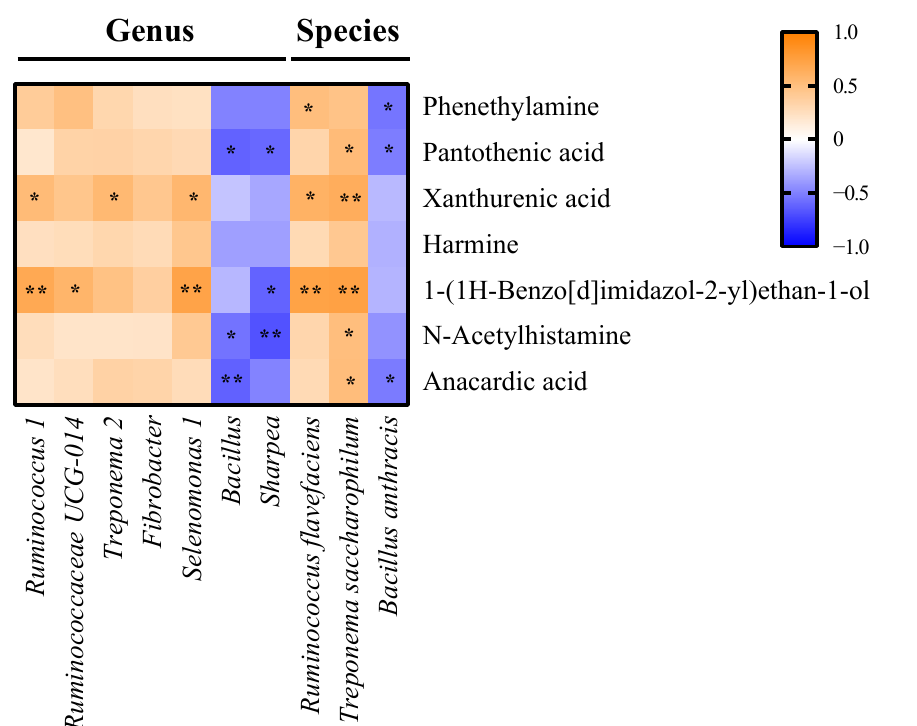
Figure 6. Reciprocal interrelationships between the ruminal microbiota and metabolome by Spear- man’s correlation test shown at the genus and species levels. Orange and blue colors indicate positive and negative correlation coefficients, respectively. Symbols indicate the significant correlation be- tween metabolites and biomarkers (* p < 0.05; ** p <